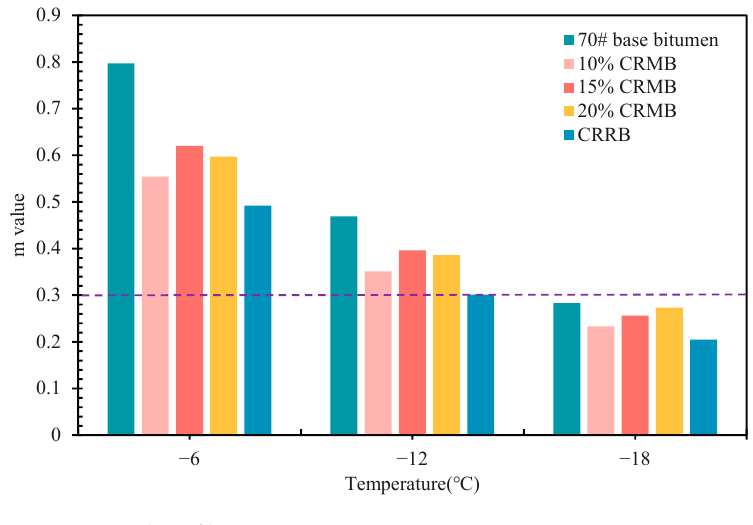
Figure 6. m value of bitumen.